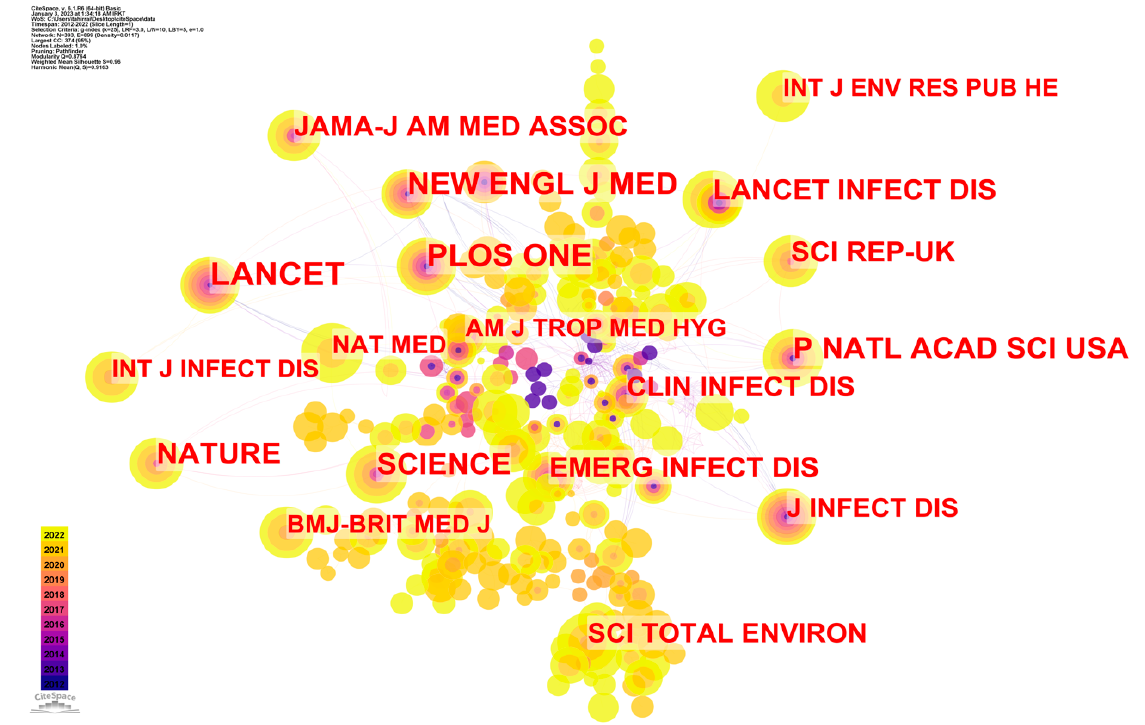
Figure 7. CS map of journal co-citation analysis of studies of epidemic control based on big data research. Table 6. Top 5 most productive journals publishing studies of epidemic control based on big data research, extracted through CS